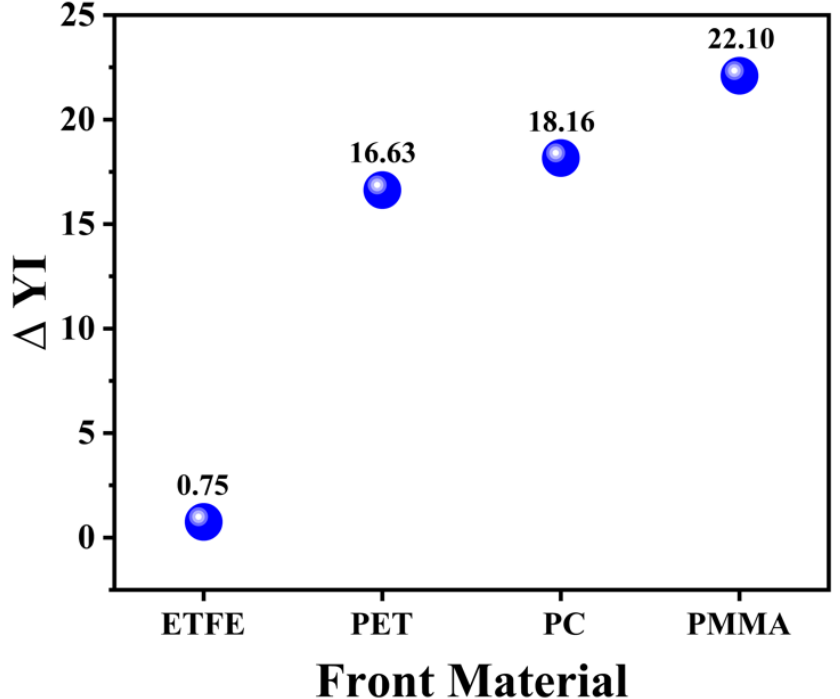
Figure 2. Change in the yellowing index of various lightweight front materials after UV testing. The change in the YI affected the transmittance of the material. This was confirmed by the change in the transmittance. Figure 3 depicts the transmittance analysis of the front material before and after UV testing in the wavelength spectrum of 300–1200 nm. Table